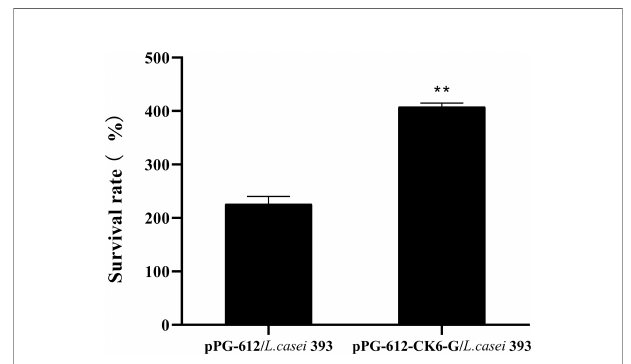
FIGURE 6 | Effect of oral administration of pPG-612-CK6-G/ L.casei 393 on lymphocyte proliferation at day 60 after secondary immunisation. Data are presented as mean ± SD and P values were calculated using one-way ANOVA and LSD post hoc tests. ** represents p <0.01.